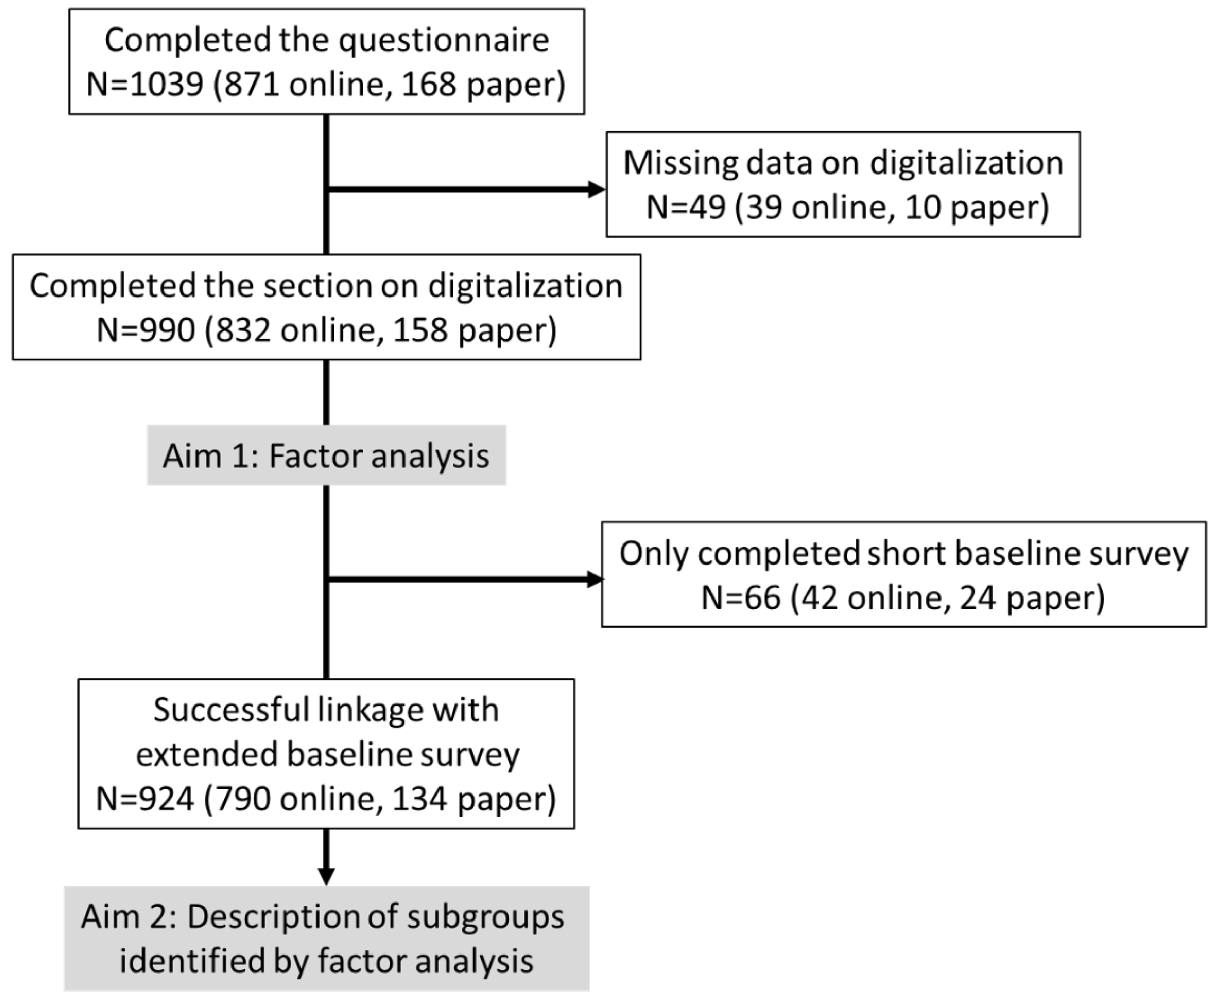
Fig 1. Study flow